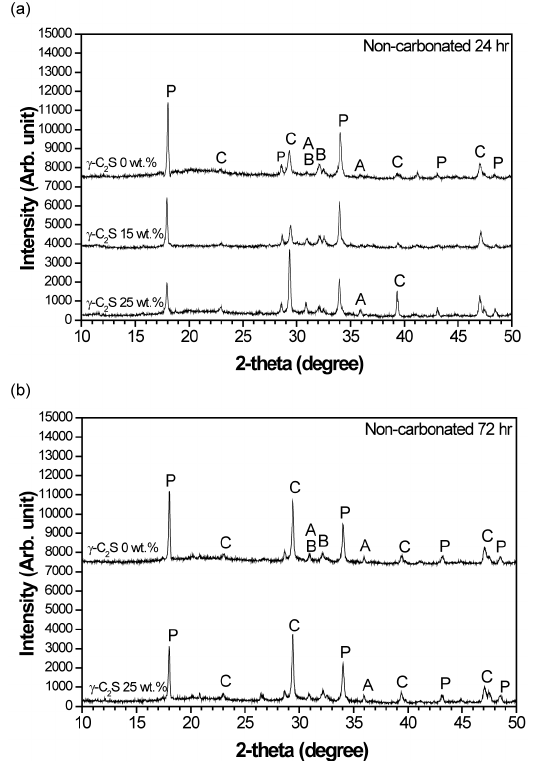
Figure 3. XRD results on the non-carbonated (purple) inner regions of the blocks ( a ) at 24 h and ( b ) 72 h. P = portlandite (Ca(OH) 2 ); C = calcite (CaCO 3 ); B = belite (C 2 S); A = alite (C 3 S).